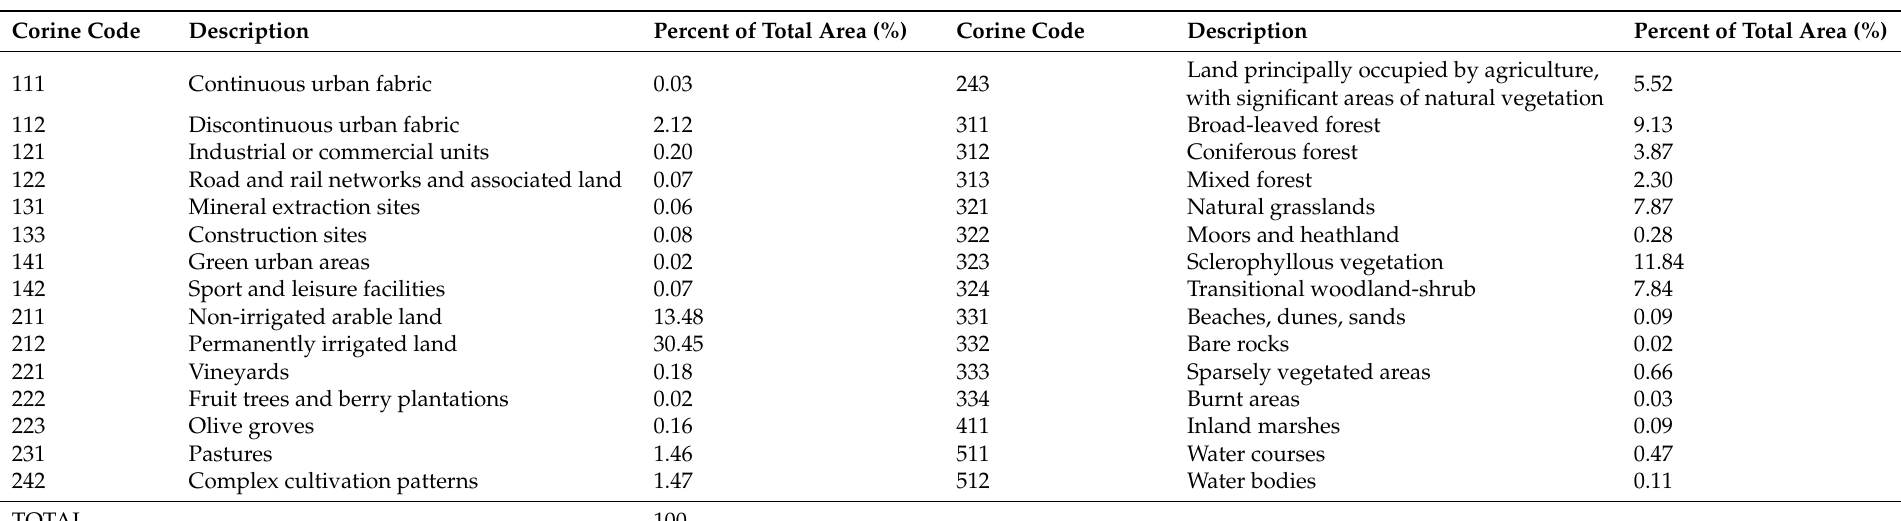
Table 1. Corine land use/land cover types for the study